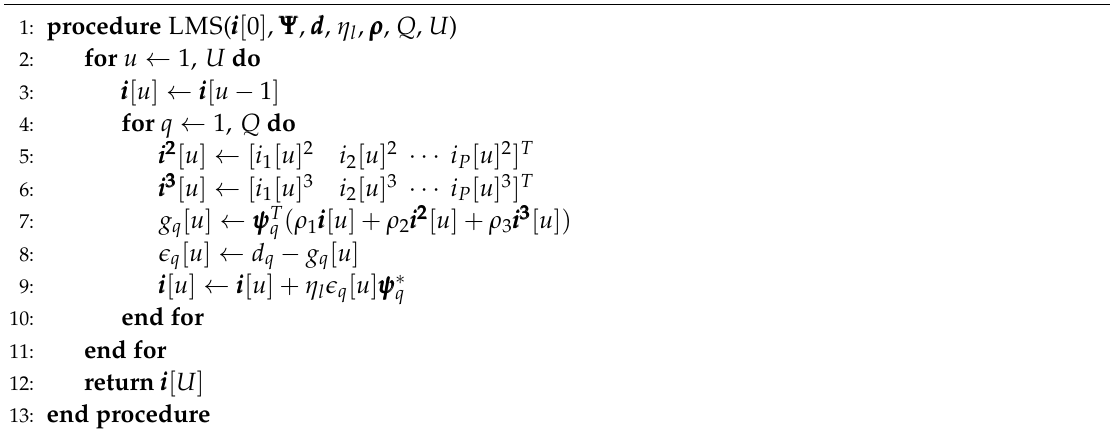
Algorithm A2 LMS for